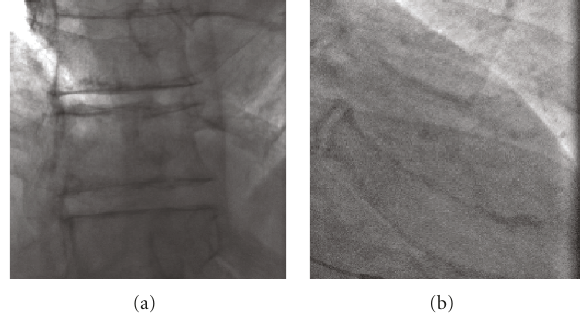
Figure 15: The two images from high-dose exams used to form the two moving layers in the realistic sequence generation. (a) is an image from an abdominal exam, and (b) is an image from a cardiac